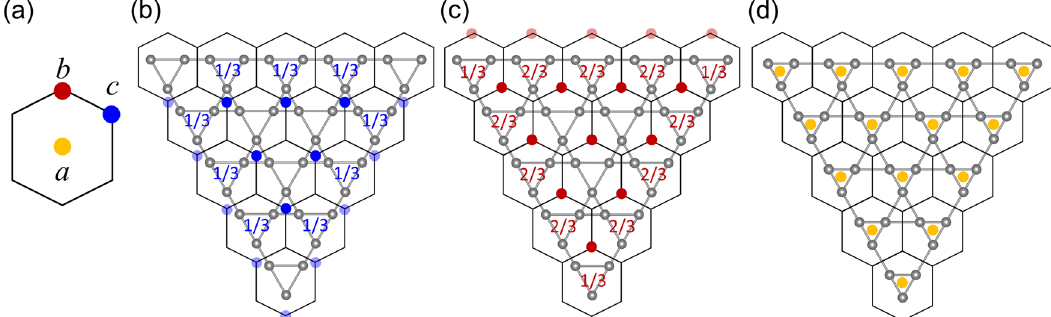
Fig. 2 Wyckoff position of ML Nb 3 TeCl 7 . a The black hexagons represent unit cell with C 3 symmetry. The English letters a , b and c inside the unit cell indicate the maximal Wyckoff positions. b , c The Wannier center at position c and b for Con fi guration 1, which is stacked by big triangles. d The Wannier center at position a for Con fi guration 2, which is stacked by small